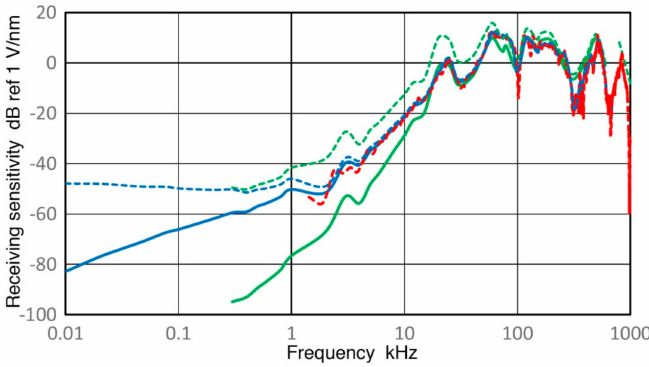
Figure 15. Receiving displacement sensitivity spectra are shown against log-frequency (in kHz) for MA-bls 40 sensor in dB in reference to 1 V/nm using two Z in of 1 M Ω (blue) and 10 k Ω (green). Corresponding pulse sensitivity spectrum is in red dash curve and calculated open-circuit sensitivities are in blue dot (using data of Z in of 1 M Ω ) and in green dot (10 k Ω )